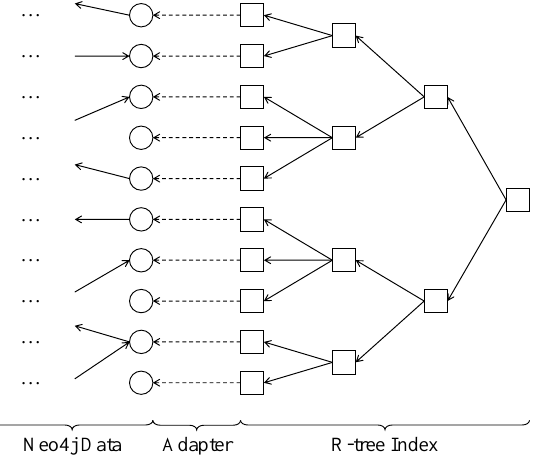
Figure 8. Illustration of an adapter (middle) connecting spatial indices in Neo4j Spatial (right) with data stored in Neo4j (left).